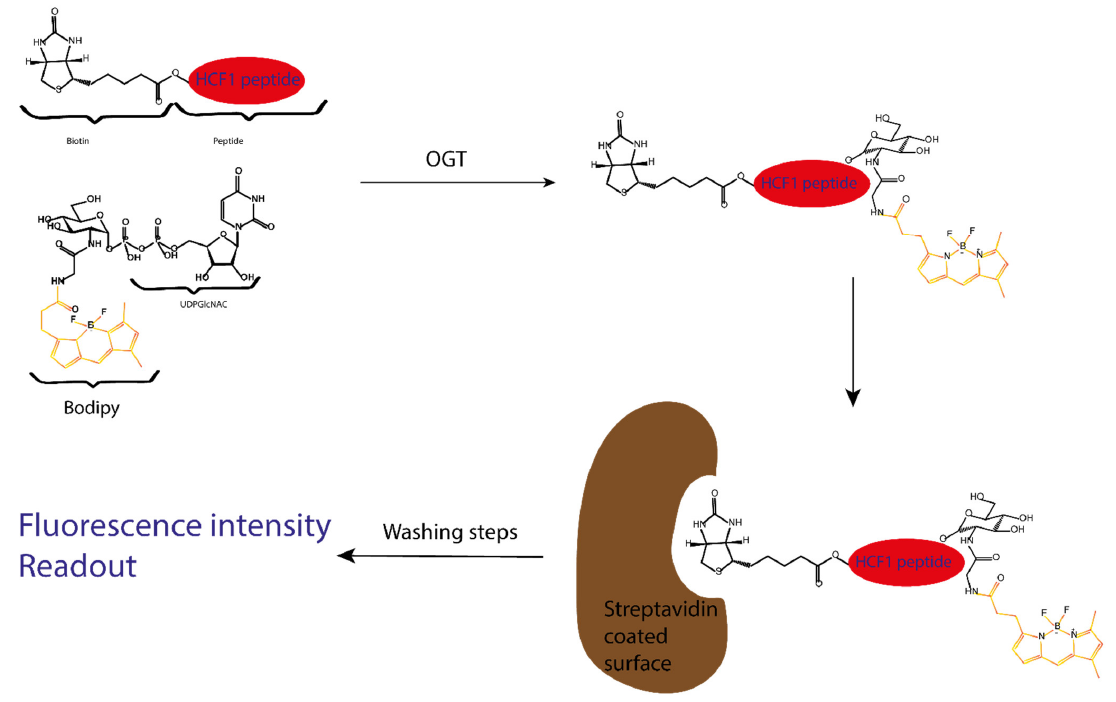
Figure 12. Schematic representation of the Vocadlo group fluorescence intensity assay. First, the biotinylated peptide acceptor is GlcNAcylated in the presence of OGT and the fluorescently labelled UDPGlcNAc. After the reaction, a mixture of fluorescent GlcNAcylated peptide and the native biotinylated peptide is present: the ratio of both reflects the reaction rate, which diminishes if OGT is inhibited.